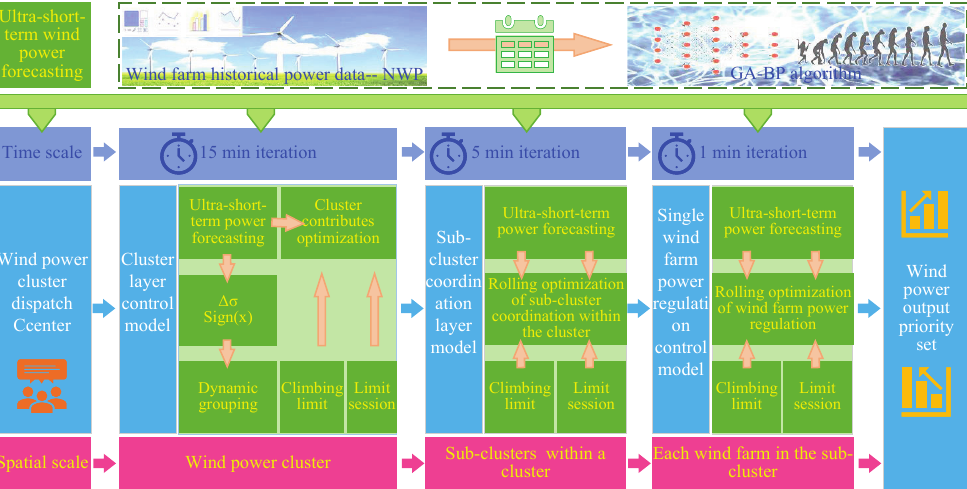
Figure 2. Active power stratification predictive control strategy for wind power cluster with multiple temporal and spatial